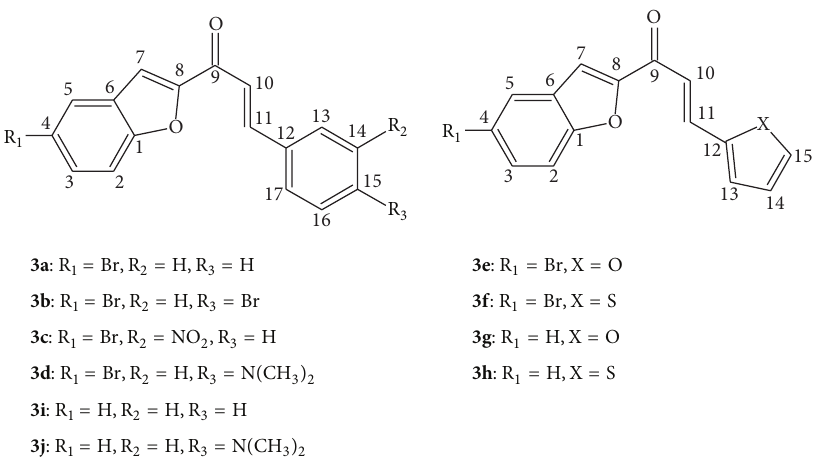
Scheme 1: Structure of synthetic derivatives 3a – 3j